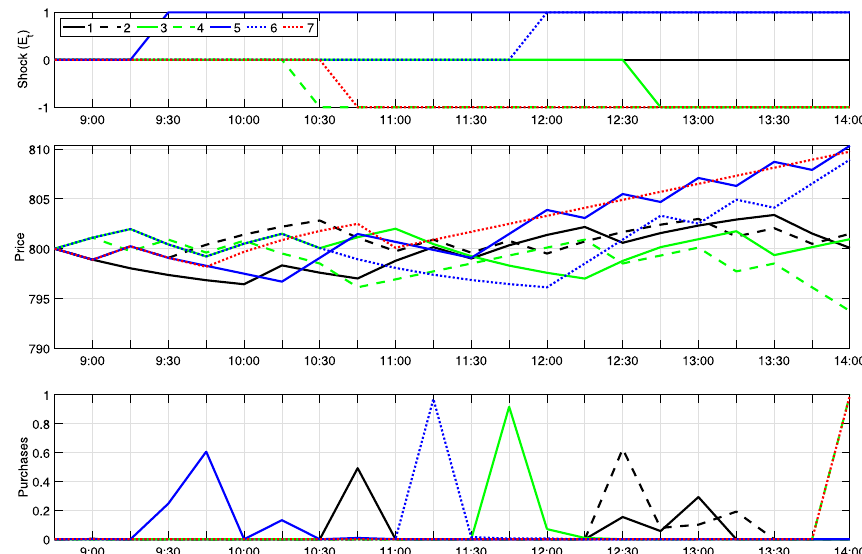
Fig. 3 RN solutions for seven representative scenarios. The first plot shows the value of state variable E t , which tracks whether there is a change in the FX price dynamics: 0 if prices follow the mean‑reverting process of Eq. (12) and 1 ( 1) if prices follow the GBM of Eq. (13) with an upward (downward) trend. The − second plot shows the evolution of the FX prices and the third plot shows the fraction purchased (amount purchased from total demand of D =